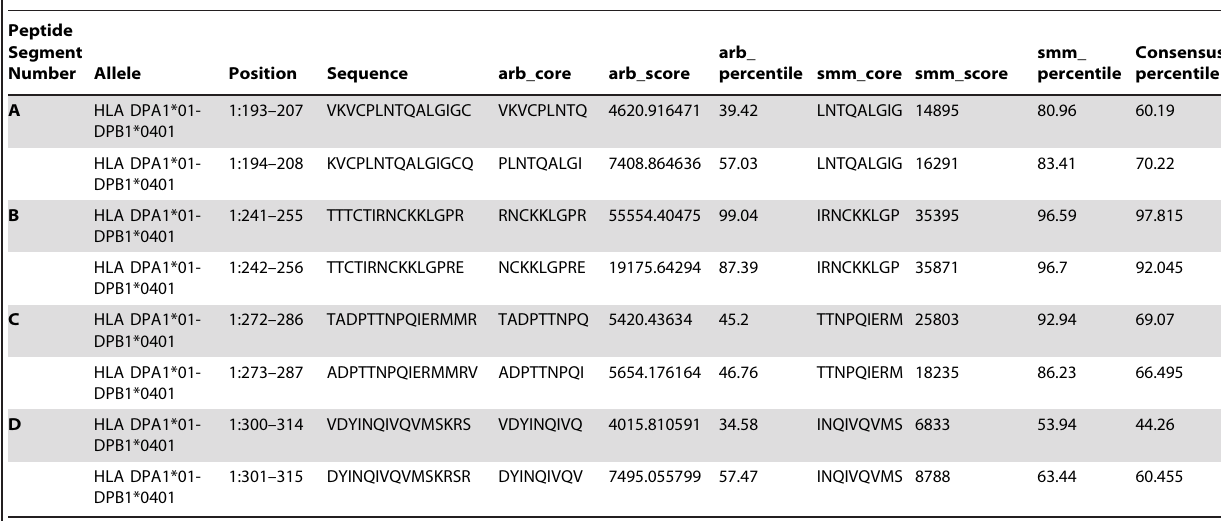
Table 2. MHC-II binding results for the identified four peptide segments.